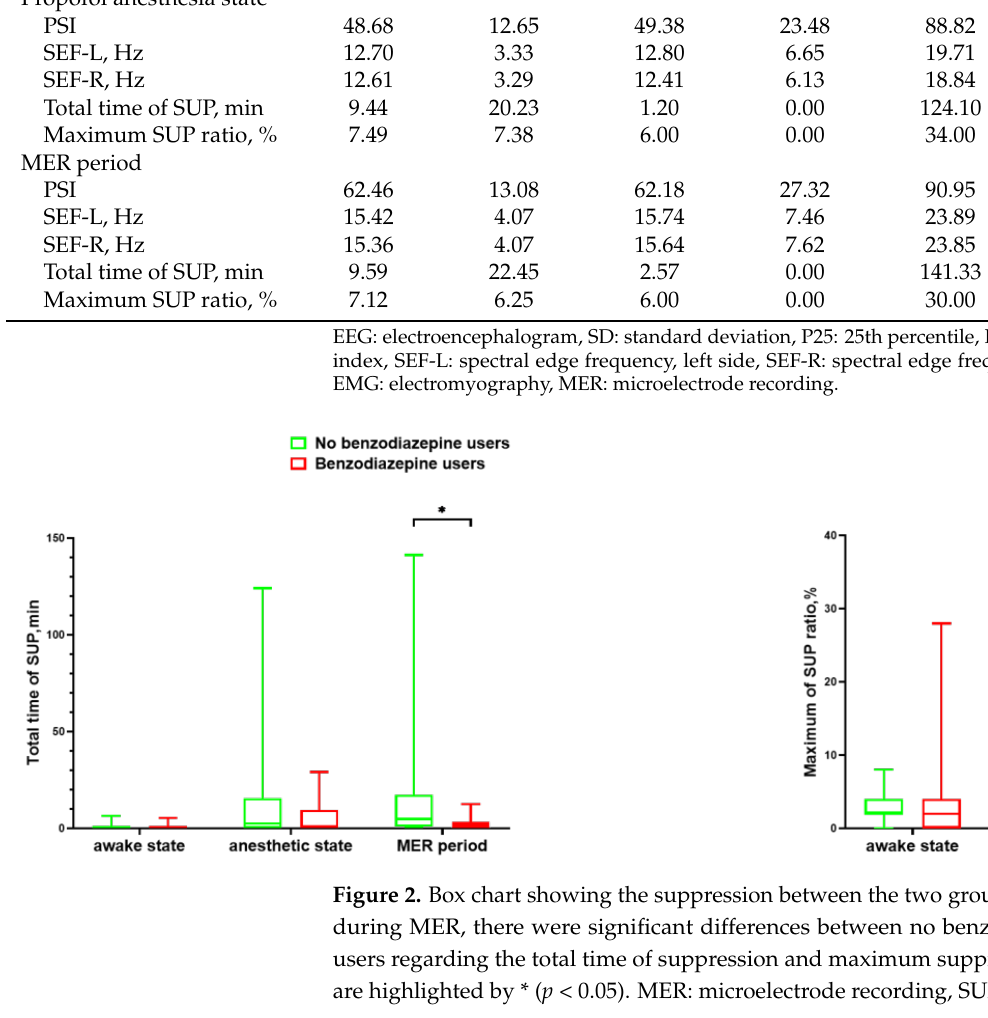
Table 3. EEG parameters in patients with Parkinson’s disease in the three states during deep brain stimulation in the subthalamic nucleus (n = 43).